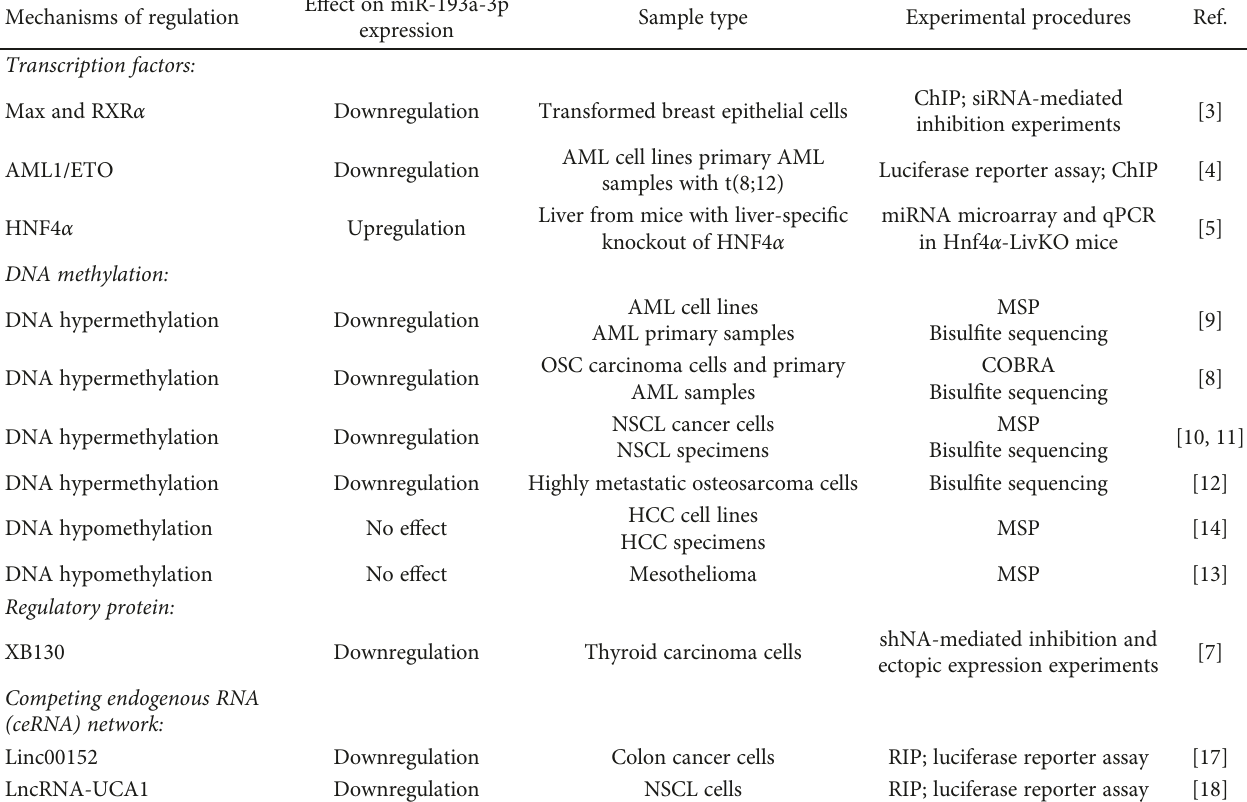
Table 1: Regulation of miR-193a-3p expression by di ff erent